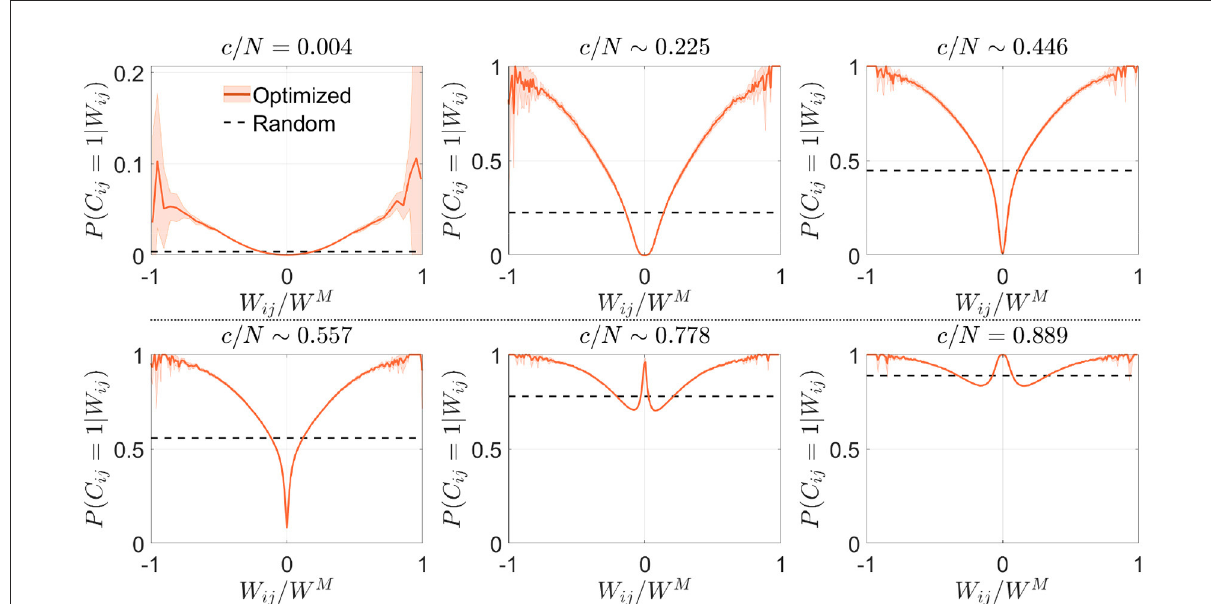
FIGURE7 Optimization by signal reinforcement preferentially selects connections with high absolute synaptic weight. Distribution of the conditional probability of having a connection between two neurons given their associated Hebbian weight for networks optimized by signal reinforcement (orange; mean ± s.d.; N = 5,000) or with random connectivity (black; theoretical mean). Each panel corresponds to a different value of the connectivity (indicated). Note that fluctuations are observed near | W ij / W M | ∼ 1 due to low sampling, as in Figure 2. Pool of data corresponding to five simulations for each